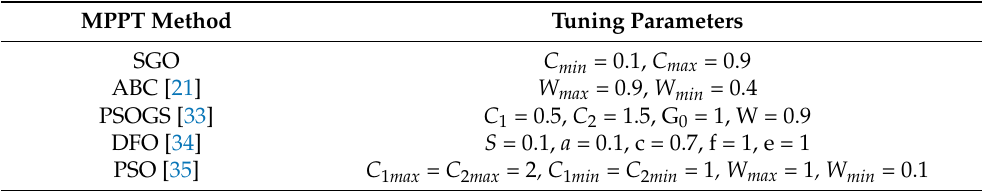
Table 2. Tuning parameters for MPPT algorithms under comparison.